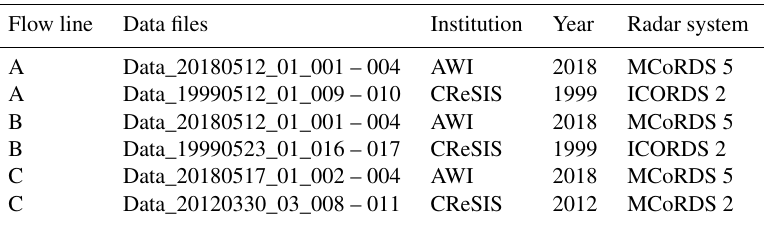
Figure 1. (a) Overview of past and ongoing deep ice-core drilling projects on the GrIS (surface elevation and Greenland contour lines by Simonsen and Sørensen, 2017; Greene et al., 2017) and the outline of the study area. The NEGIS appears as a distinct feature in the surface velocities (Joughin et al., 2018). It extends from the central ice divide to the northeastern coast, where it splits up into the three marine- terminating glaciers: 79N Glacier, Zachariae Isbræ and Storstrømmen Glacier. (b) The present-day EastGRIP flow line is derived from the DTU-Space-S1 surface velocity product (Andersen et al., 2020). Due to the limited availability of radar data along the flow line, we construct three approximate flow lines through a combination of various radar products (profile A–C) between GRIP and EastGRIP. Flow line B and C lack data in the centre of the profiles, marked as a dashed line. The downstream parts of line A and B comprise the same radar profile, which crosses the southern shear margin around 82km upstream of EastGRIP. Table 1. RES profiles used to approximate the EastGRIP flow lines A–C. The data sets were measured between 1999 and 2018 by the Center for Remote Sensing of Ice Sheets (CReSIS; CReSIS, 2021) and the Alfred Wegener Institute, Helmholtz Centre for Polar and Marine Research (AWI; Jansen et al., 2020; Franke et al.,